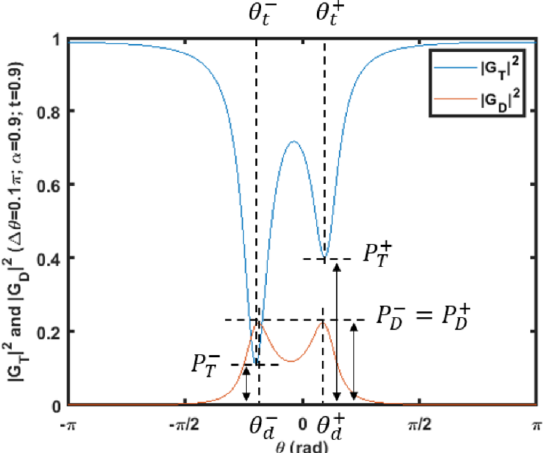
Figure 8. Notations for resonant peaks in | G t | 2 and | G d | 2 with ∆ θ = 0.1 π . The power transmission of the resonant peaks is denoted by P ± to describe resonant peaks on the left ( − ) and right (+) hand side. θ ± denotes the phase of the resonant peaks